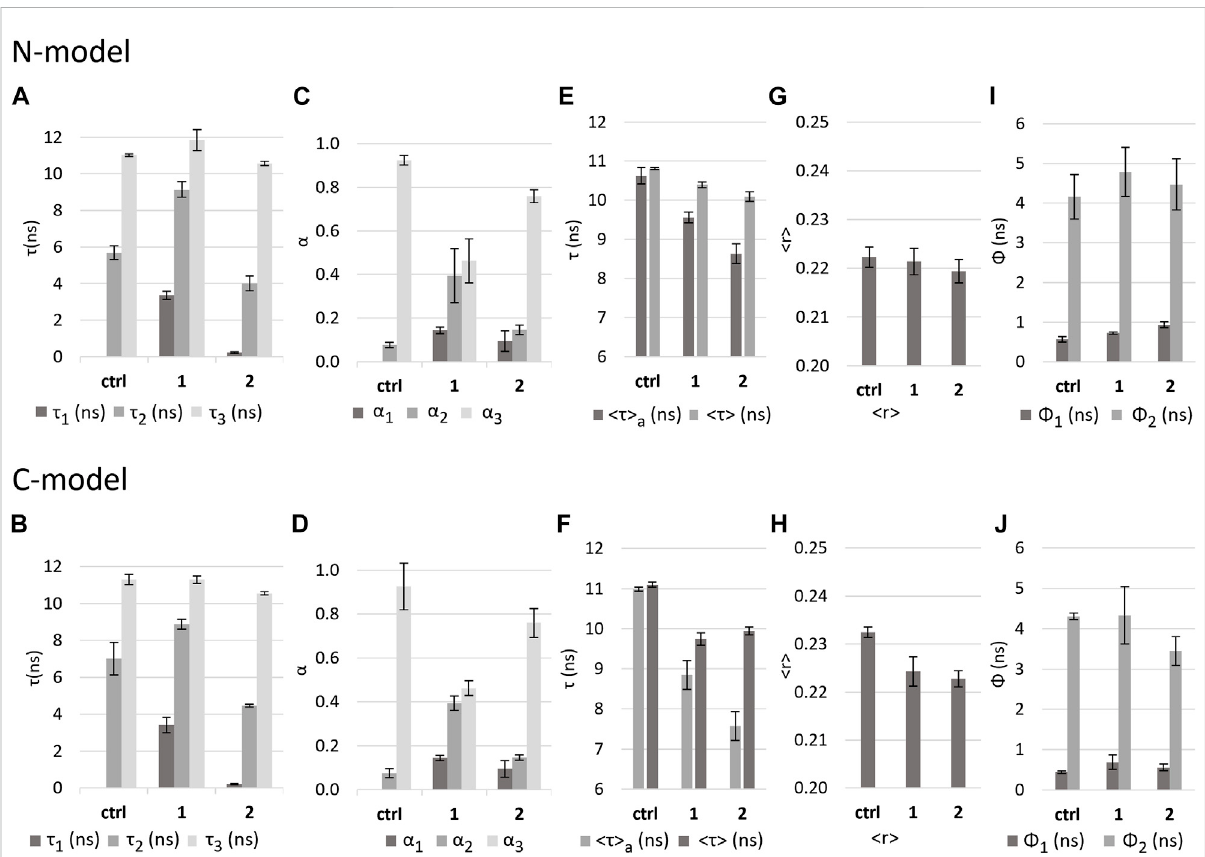
FIGURE 8 Effect of the complexes on N-model and C-model as reported by DPH fl uorescence properties. Values in the absence (control - ctrl) and presence of complexes 1 and 2 in buffer 3 of (A,B) : fl uorescence decay lifetime components; (C,D) : amplitudes associated with each component; (E,F) : intensity-weighted mean fl uorescence lifetime ( < τ > ) and amplitude-weighted mean fl uorescence ( < τ > a ) lifetime. (G,H) : calculated fl uorescence anisotropy in steady state < r > ; (I,J) : rotational correlation times V